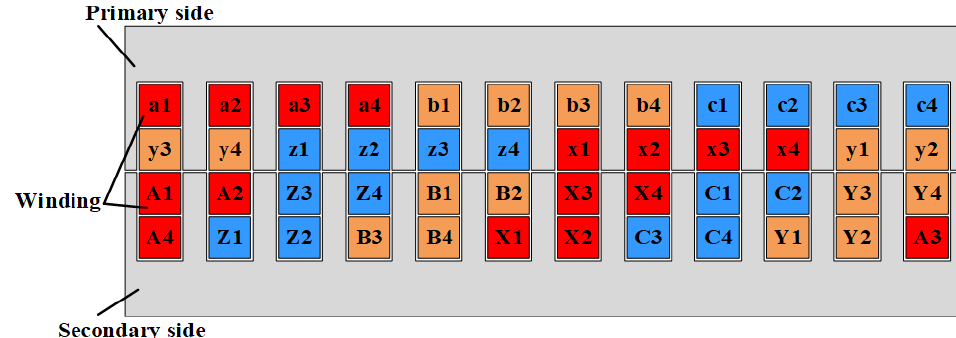
Figure 1. Schematic diagram of UP-LPST structure.